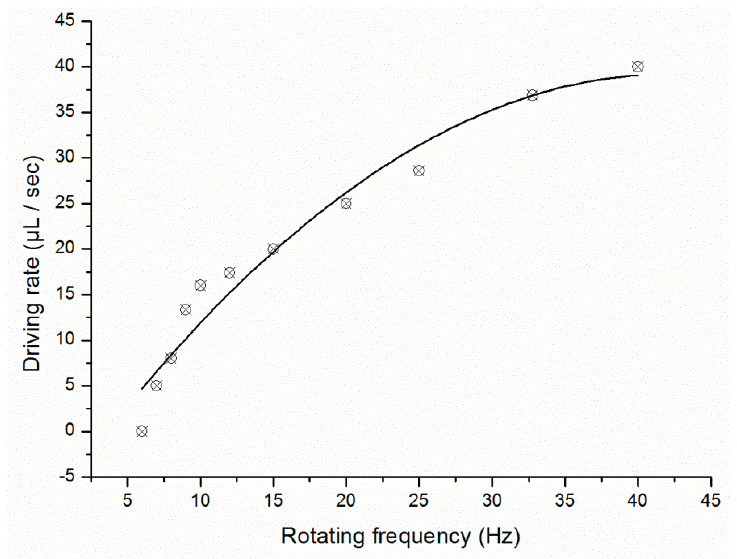
Figure 4. Relationship between sample flow rate and rotating frequency of the fluid control unit.